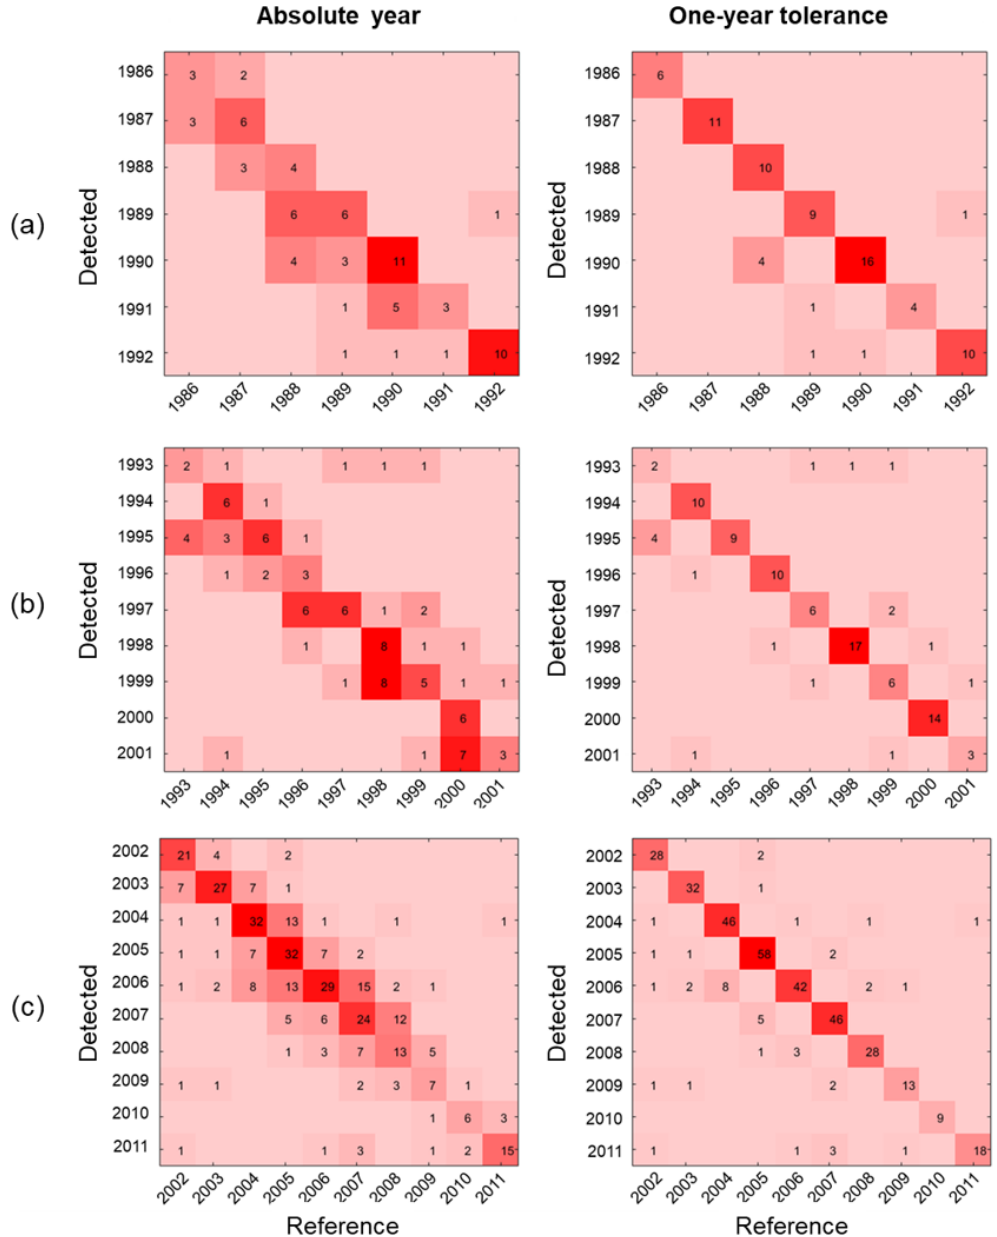
Figure 9. Accuracy assessment of urbanized years over different periods B1 (1985–1992) (a) , B2 (1992–2001) (b) , and F1 (2001–2011) (c) . Each grid labels the urbanized year from the manual interpretation (reference) and our approach